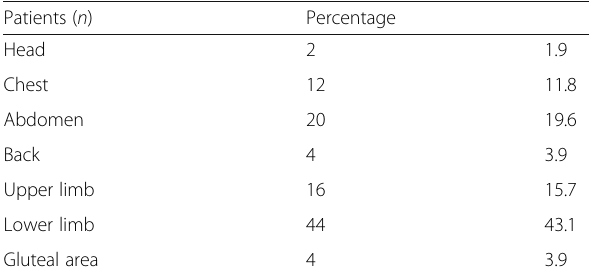
Table 2 Anatomical patterns of firearm injuries in patients ( n = 102)